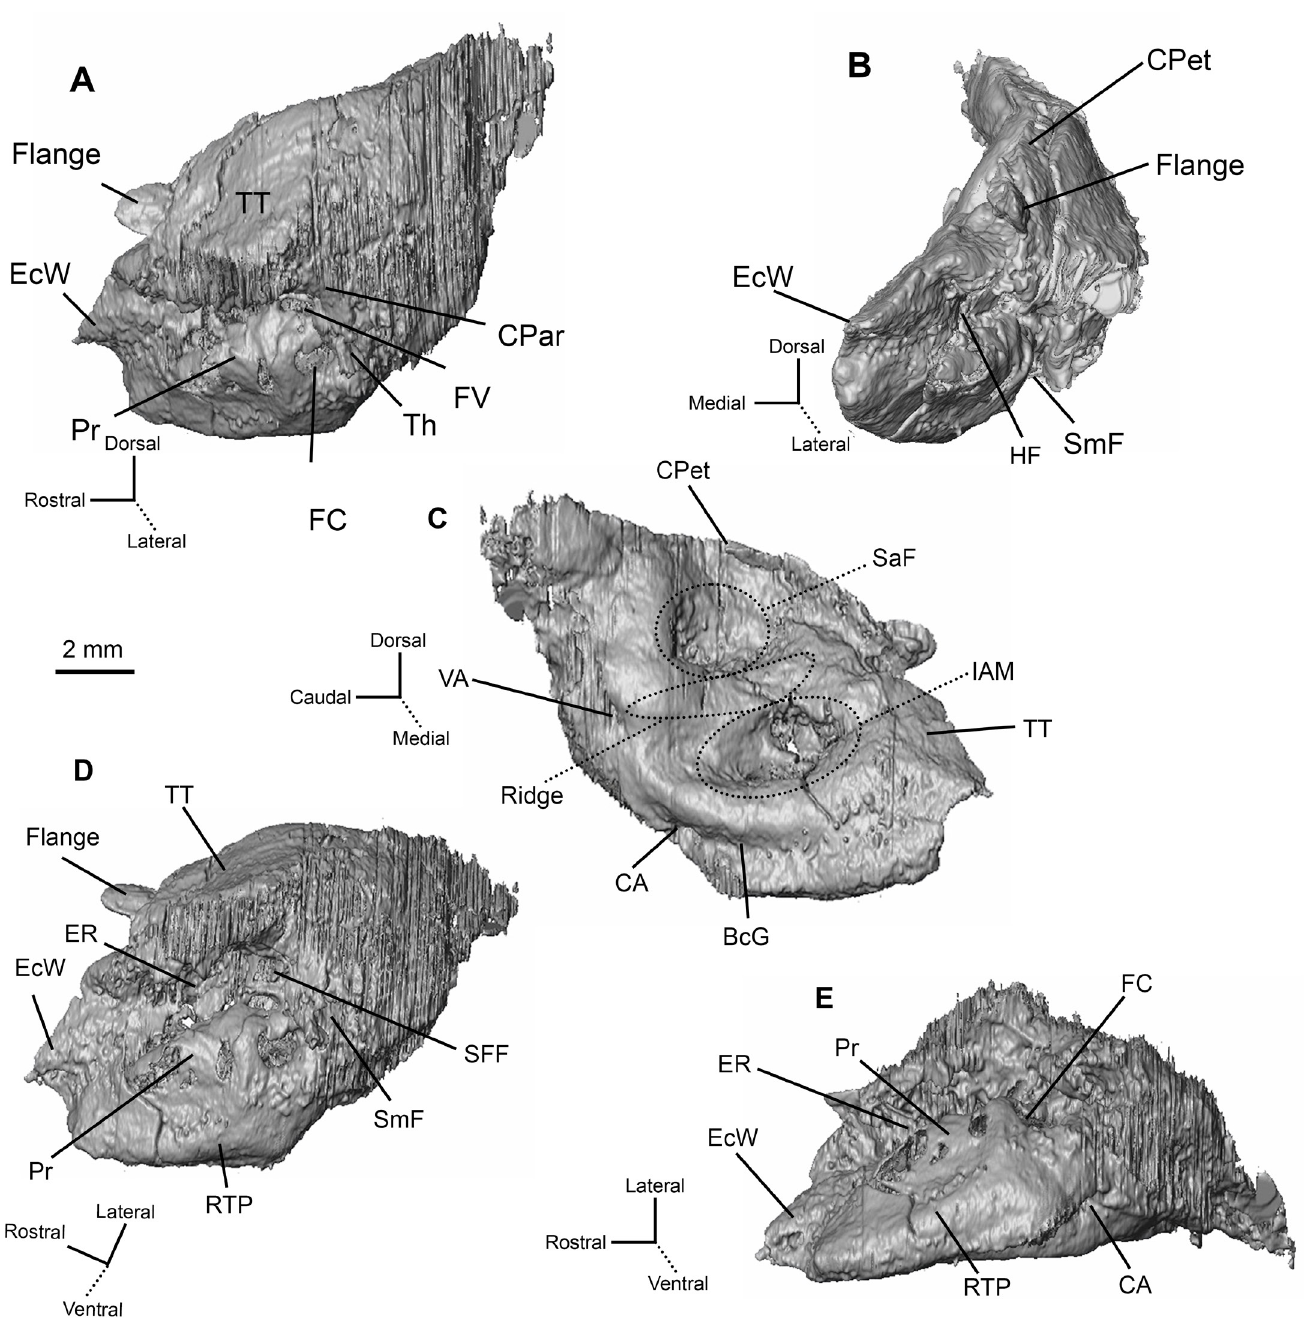
Figure 3. Five views of the right petrosal of SDSNH 47878. Images are mirrored so that the rostral direction is to the left of the image. A, lateral view; B, rostral view; C, endocranial (medial) view; D, tympanic view; E, ventral view. Abbreviations: BcG, basicapsular groove; CA, cochlear aqueduct; CPar, crista parotica; CPet, crista petrosa; EcW, ectotympanic wing; ER, ecto- tympanic recess; FC, fenestra cochleae; FV, fenestra vestibuli; HF, hiatus Fallopii; IAM, internal acoustic meatus; Pr, promon- torium; RTP, rostral tympanic process; SaF, subarcuate fossa; SFF, secondary facial foramen; SmF, stylomastoid foramen; Th, tympanohyal; TT, tegmen tympani; VA, vestibular